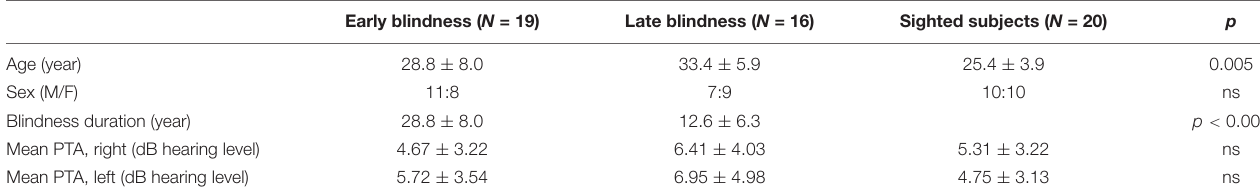
TABLE 1 | Comparison of age, sex, and pure-tone average among early blindness group, late blindness group and sighted control